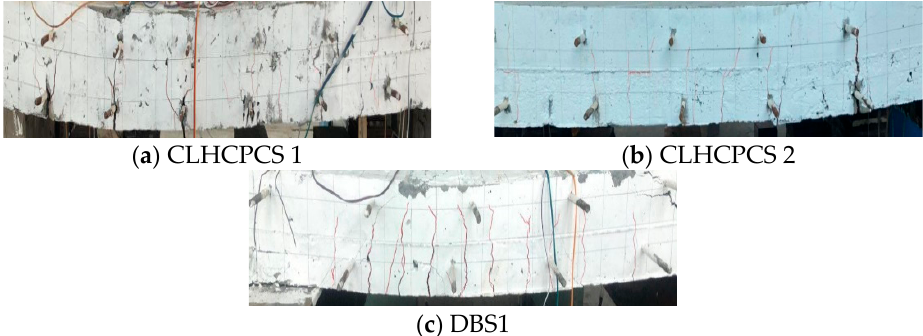
( c ) DBS1 Figure 19. The Crack pattern at the bottom of the three composite slabs. 3.6.1. Analysis of Load − Strain Curve Results of CLHCPCS Reinforcement The load − strain of CLHCPCS reinforcement is shown in Figures 20–22. Figure 20. Load − strain curve of CLHCPCS reinforcement. Figure 20 shows that at the beginning of the load increase, the strain of the three kinds of composite slab truss bars increases linearly. Under applied uniformly distributed load 8.90 kN/m 2 , the concrete cracks appear. Along with the crack development, concrete be- gins to deactivate. The load is gradually borne by the longitudinal tensile bar and lower chord of the truss bar until the composite slab damage occurs. The strain value grows slowly and gradually stabilizes in the later stage. The longitudinal tensile bar and the lower chord of the truss bar form an excellent primary and secondary beam structure, with the lower chord bearing part of the force transmitted by the reinforcement. The com- posite slab has good mechanical performance during the whole load − holding process.